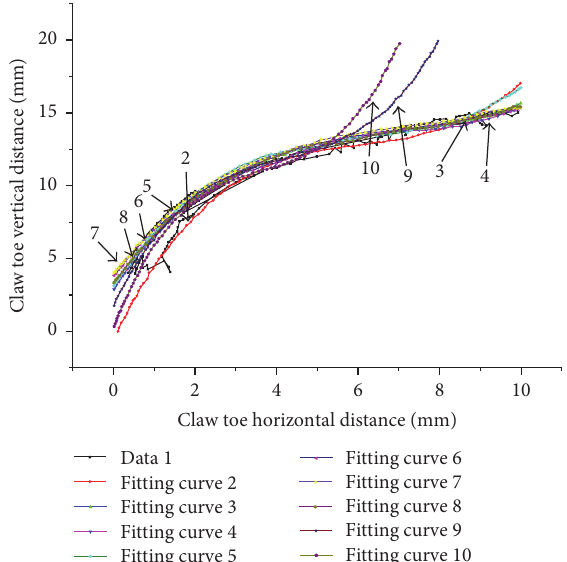
Figure 8: The polynomial fitting curve of the internal contours of the Himalayan marmot’s second front claw.